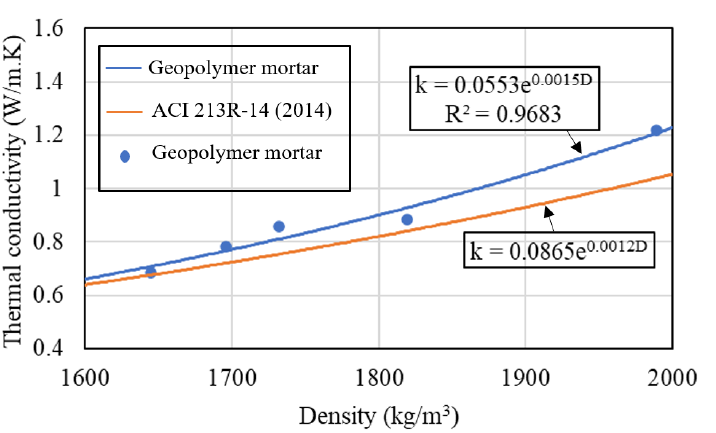
Figure 14. Relationship between density and thermal conductivity of geopolymer mortar containing BLWA compared with the equation of ACI 213R-14 [58].